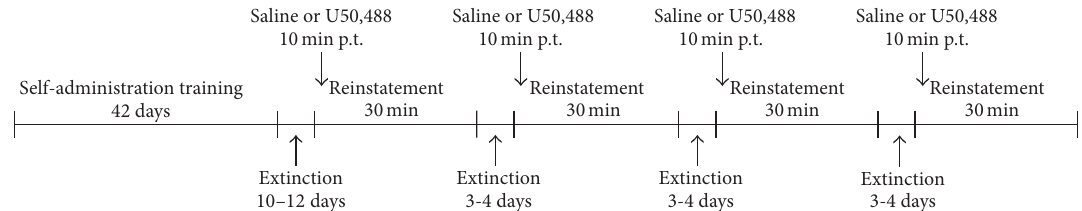
Figure 1: Experimental timeline for U50,488-induced reinstatement testing. Rats ( 𝑛 = 13 ) were trained to self-administer ethanol, and then lever pressing was extinguished. Following extinction rats were injected with U50,488 (0.1–10mg/kg, i.p.) or saline 10 minutes prior to testing. Tests were conducted every 3-4 days, with rats experiencing extinction sessions daily between test days.